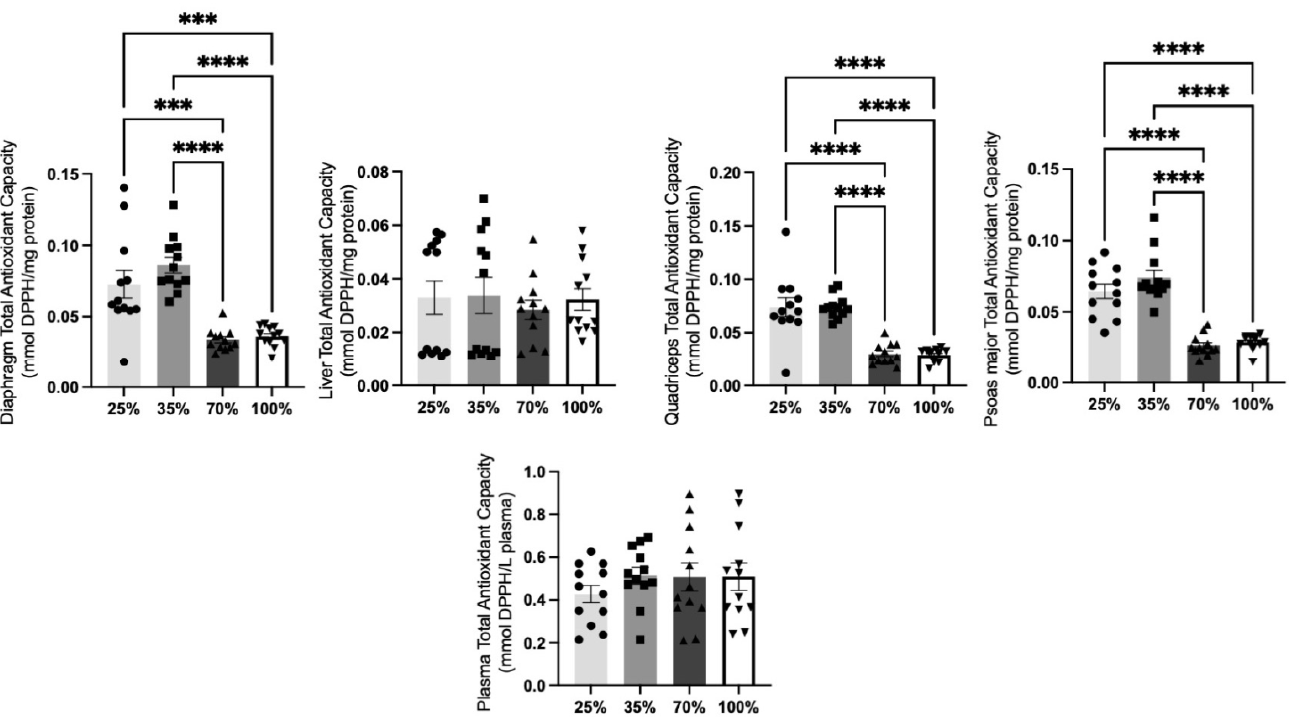
Figure 7. TAC levels at all 4 d.s. of kids. *** denotes significant difference with p < 0.001, **** denotes significant difference with p < 0.0001.